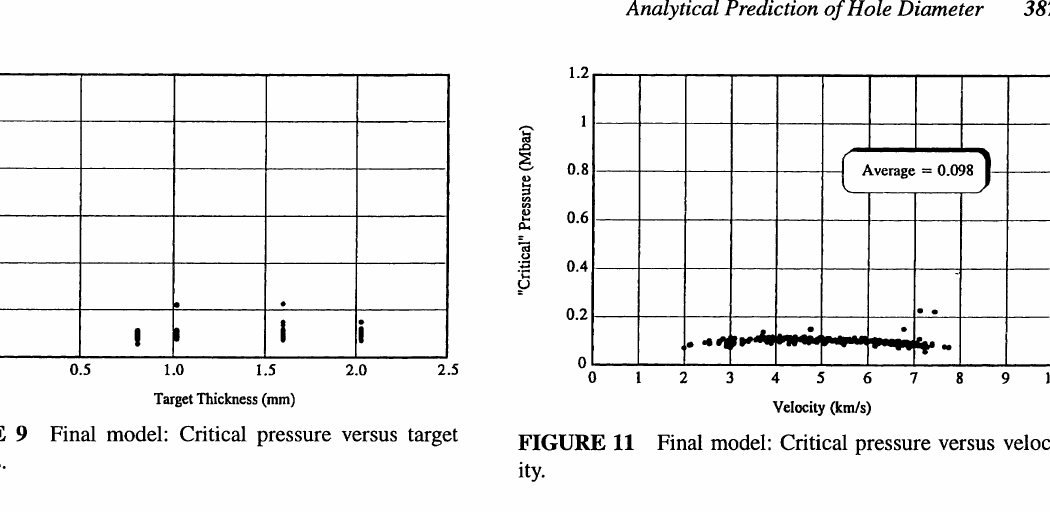
FIGURE 11 Final model: Critical pressure versus veloc